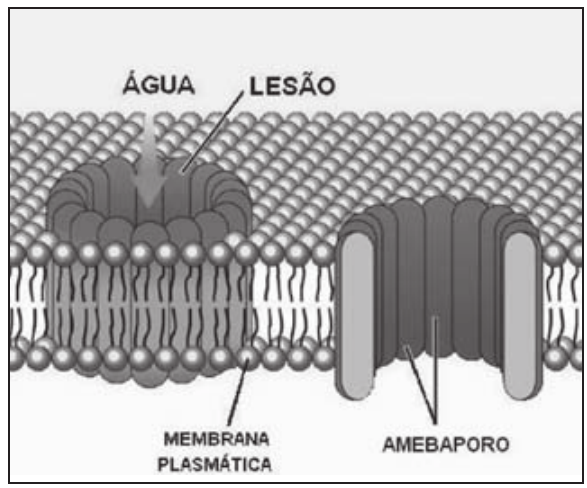
Figura 2 – Modelo esquemático representando moléculas de amebaporo inseridas na bicamada lipídica de uma célula-alvo. Observar o fluxo contínuo de água para o interior da célula. Esse mecanismo resulta em morte celular em virtude de sua lise osmótica